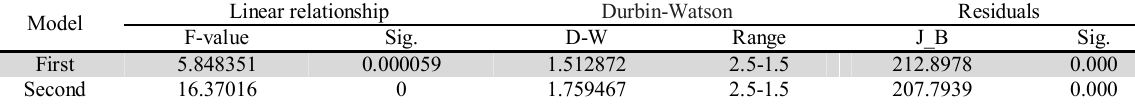
The summary of Durbin-Watson and